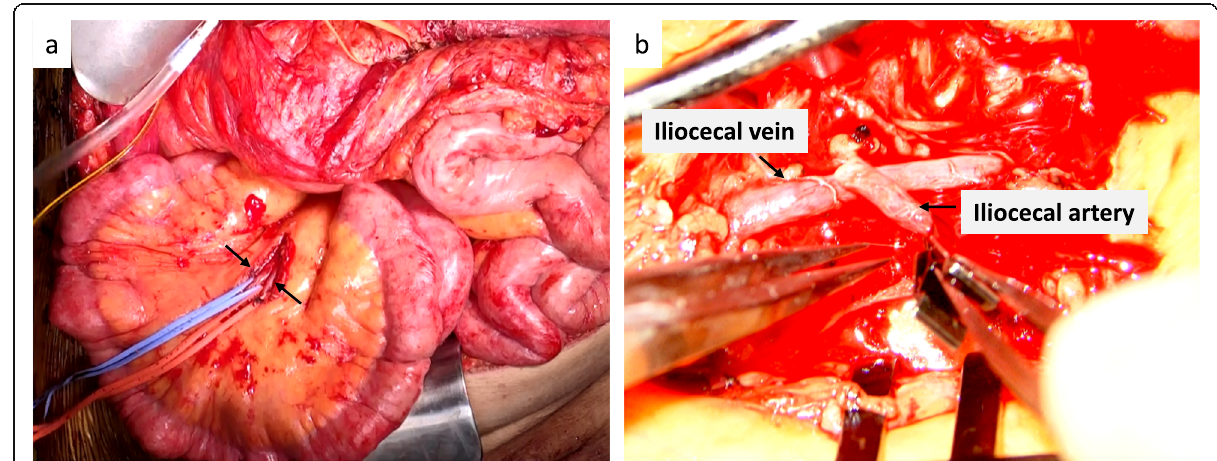
Fig. 1 a Intraoperative image of an opened mesoileum and selected ileocecal artery and vein, which were taped (arrow). b Ileocecal artery anastomosed to the vein in an end-to-side fashion with 9-0 Nylon